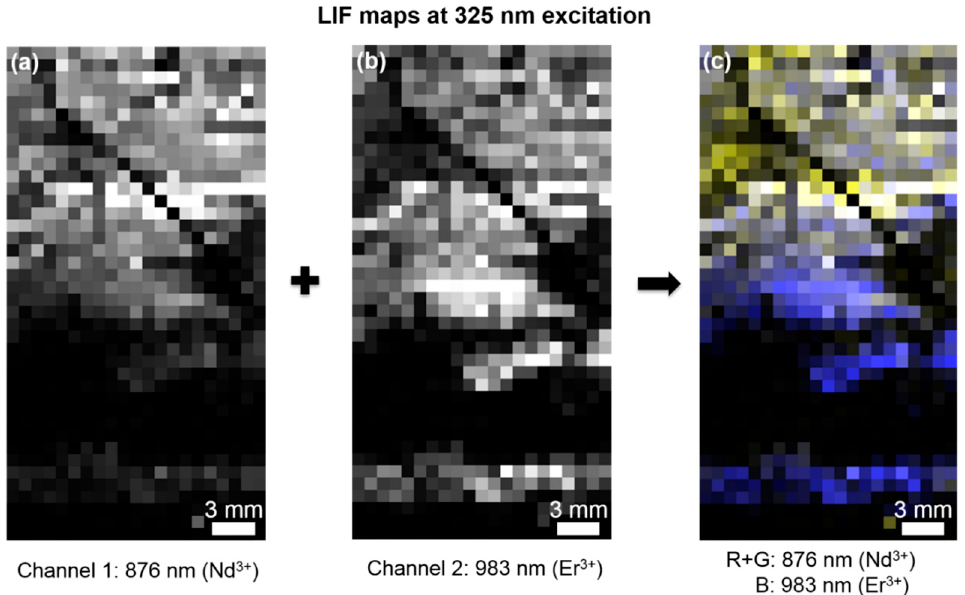
Figure 5. 2D LIF maps from the Lofdal sample after excitation with a 325 nm laser at a pixel step size of 1 mm. ( a , b ): The grayscale images show the relative intensities of a certain emission wavelength/spectral band, which is related to the occurrence of a specific REE 3+ ion. ( c ) The normalized combination of both maps results in a false-color RGB map of the sample, where the “red” and the “green” channels are combined. Thus, yellow pixels represent a higher Nd 3+ -related signal and dark blue pixels a higher Er 3+ -related signal. Dark areas do not show any luminescence in the given wavelength ranges.